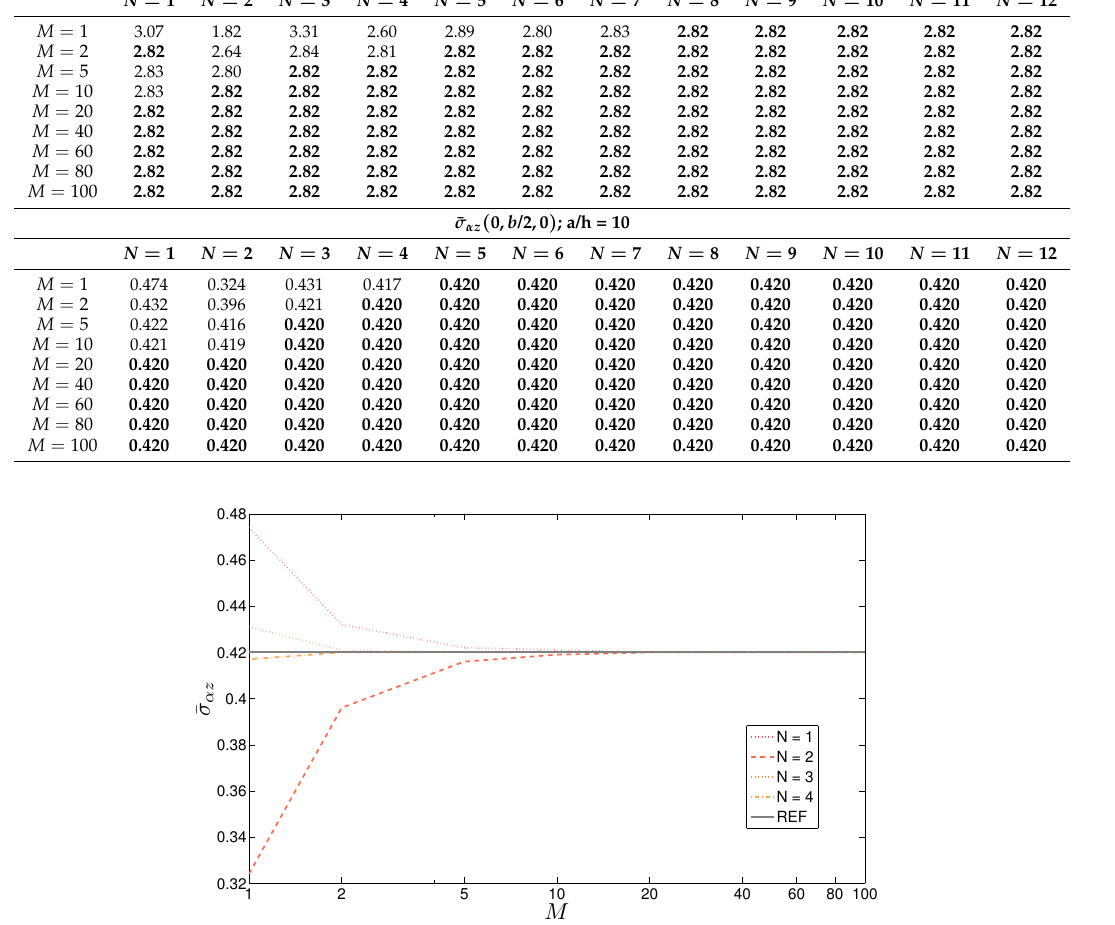
Figure 4. Case 1, simply supported rectangular laminated composite plate with thickness ratio a / h = 10. Stress ¯ σ α z vs. number M of mathematical layers introduced for different orders of expansion N for the exponential matrix. REF means a 3D solution by Pagano